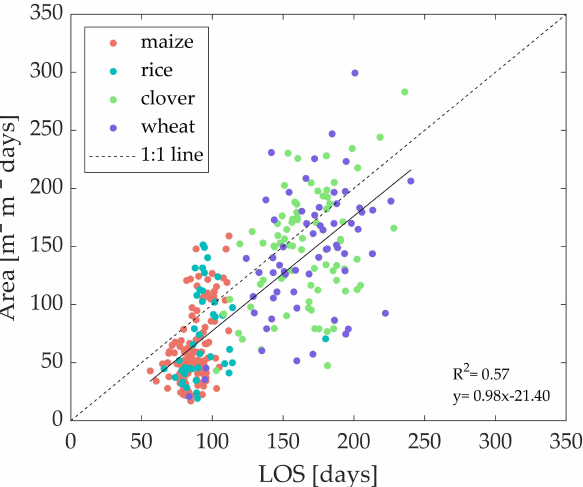
Figure 6. Comparison of Area and LOS for all crop types extracted from 2016 to 2019 SL30 GPR time series.